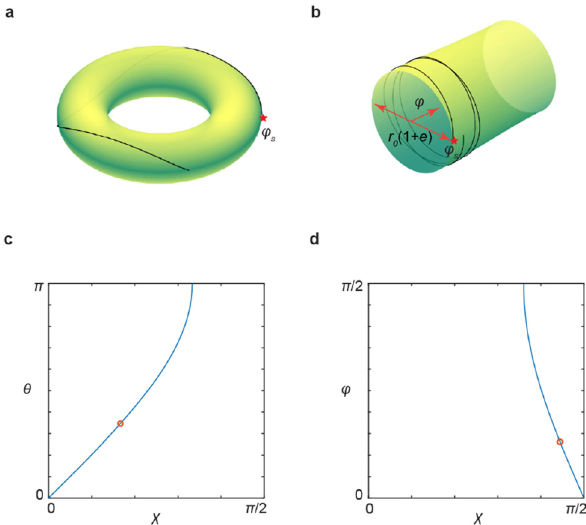
Figure 4c, where the propagation initial condition of χ = π /6 (case of Figure 3a and d) is marked as red circle. In Figure 4b, a conus is considered to account for the radius change along the φ direction in the deformed torus. By